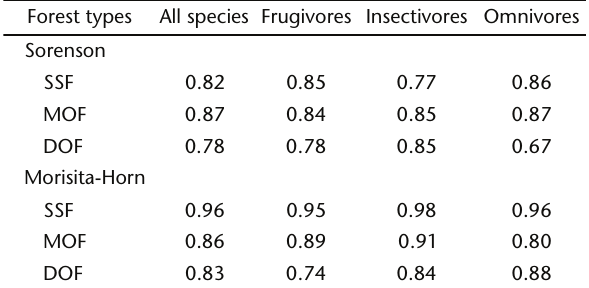
Table I. Sorenson and Morisita-Horn indexes of breeding and non- breeding season similarities for all species and functional